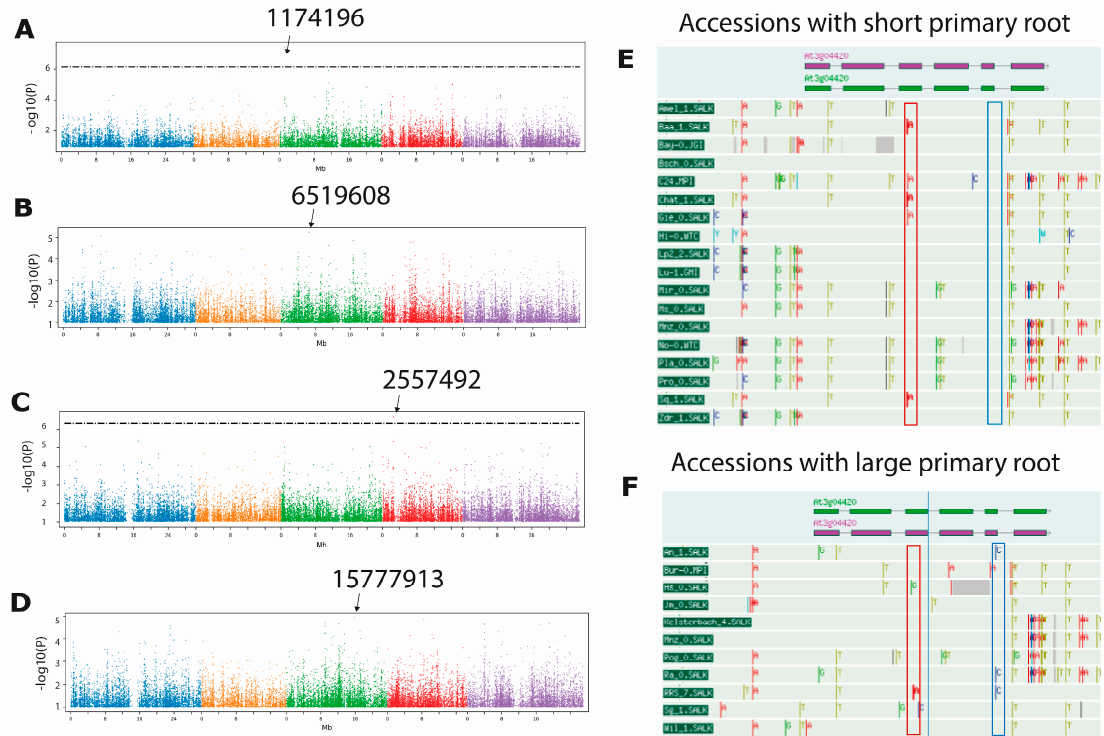
Figure 4. GWAS were performed using the median of each of the traits analyzed and significant associations were identified using an accelerated mixed model. The threshold is plotted as a dotted horizontal line. ( A ) PR length at 12 dps, ( B ) growth rate at 11/12 dps, ( C ) elongation zone and ( D ) meristem length. The position of the SNPs with high scores is indicated in the upper part of the Figure ( A – D ). ( E ) SNPs found in NAC048 homologs from accessions with short PR length. The SNP gGt/gAt in the third exon of NAC048 is found in 16% of accessions (Baa-1, Chat-1 and Sq-1), whereas the gaC/gaA change in the fifth is not present, ( F ) SNPs observed in NAC048 from accessions with large PR length, the Mrk-0 is not shown in the image since it is not found in the 1001 Genomes project page. The SNP gGt/gAt in the third exon of NAC048 is found in 8.3% (RRS-7) of accessions, whereas the gaC/gaA change in the fifth is detected in 33.3% of accessions (An-1, Mrk-1, Ra-0, RRS-7) with large